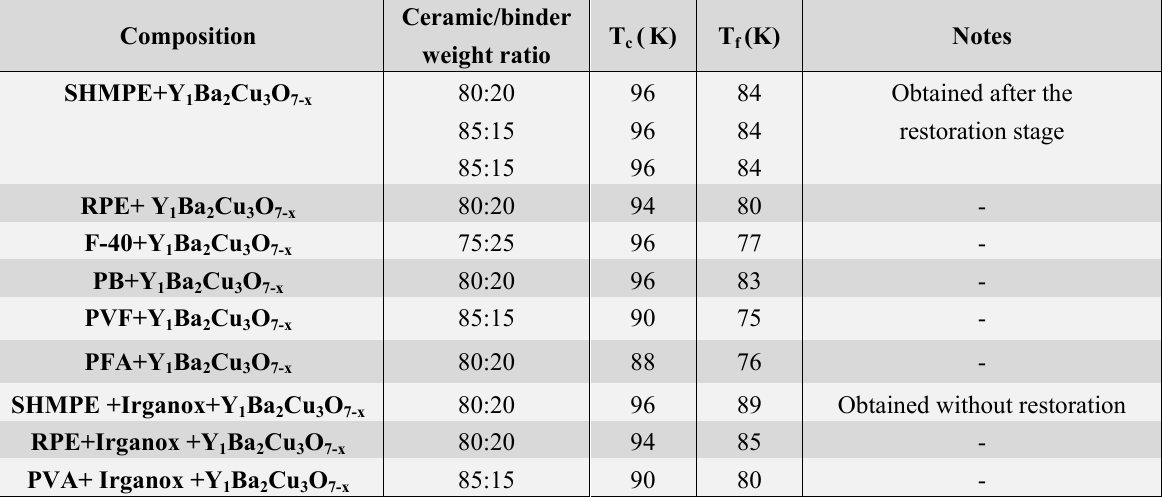
Obtained after the restoration stage